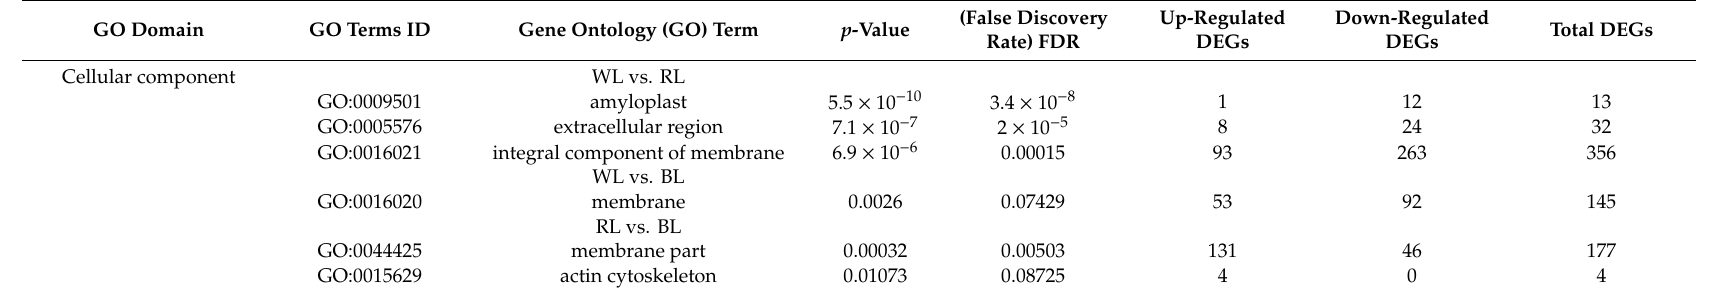
Table 2. Cellular component enrichment analyses for DEGs between di ff erent light qualities.